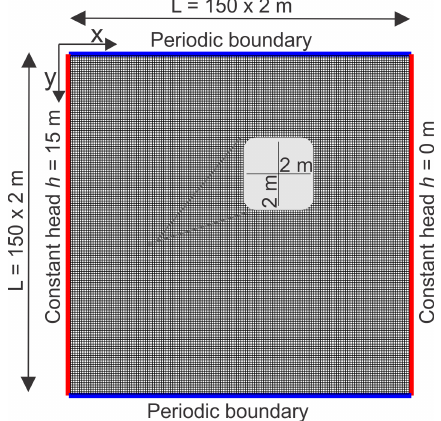
Figure 1. Modeling domain used in this work is a rectangular grid of fractures connecting 150 × 150 nodes. Each fracture is 2m long and 1m wide (see the excerpt in the middle) with initial aperture width a 0 . The left-hand and right-hand sides are constant head boundaries at 15 and 0m, respectively. Upper and lower boundaries are periodic. The x – y coordinate system is given for the node coor- dinates.